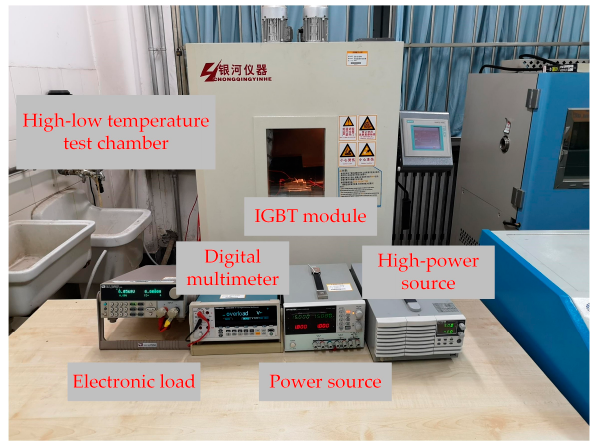
Figure 6. The on-state voltage acquisition system.